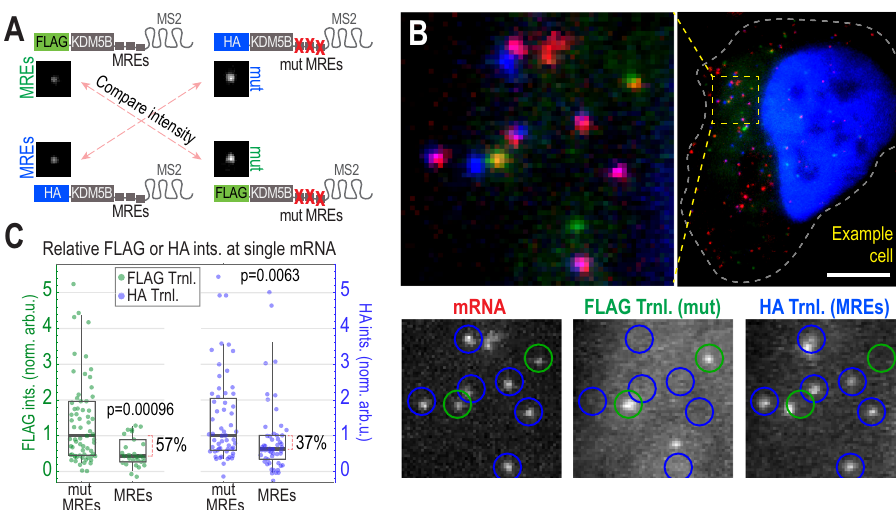
Fig. 5 miRNA-directed Ago targeting represses translation at the single-mRNA level. A Schematic of modi fi ed TnT biosensors with either endogenous miRNA Response Elements (MREs) or inactive, mutated versions (MUT) inserted in place of the tethering cassette. In each experiment, two modi fi ed biosensors (either top two or bottom two) were coexpressed in single cells. To fairly gauge relative translation signals, FLAG (or HA) signals were compared across experiments (red, dashed arrows). B An example cell loaded with the top two biosensors in A. Image above shows a whole cell and a representative cytoplasmic patch. Image below shows each separated channel from the patch (intensity auto-adjusted), with detected translating (Trnl) mRNA circled in blue (indicating translation of HA) or green (indicating translation of FLAG). N = 69 mut MREs and N = 30 MREs for FLAG; N = 58 mut MREs and N = 54 MREs for HA. Scale bar, 10 μ m. C Box plots showing the relative intensity (ints.) of the mutated MREs (mut MREs) and endogenous MREs (MREs) containing modi fi ed biosensors from 1 of 3 replicate experiments (see Supplementary Fig. 5C for the other two replicate experiments). Each point represents the measured translation signal from a single detected biosensor ( N = 69 mut MREs and N = 30 MREs for FLAG; N = 58 mut MREs and N = 54 MREs for HA). The boxes (whiskers) show the 25 – 75% (5 – 95%) range. P values were calculated using the Mann – Whitney test, two